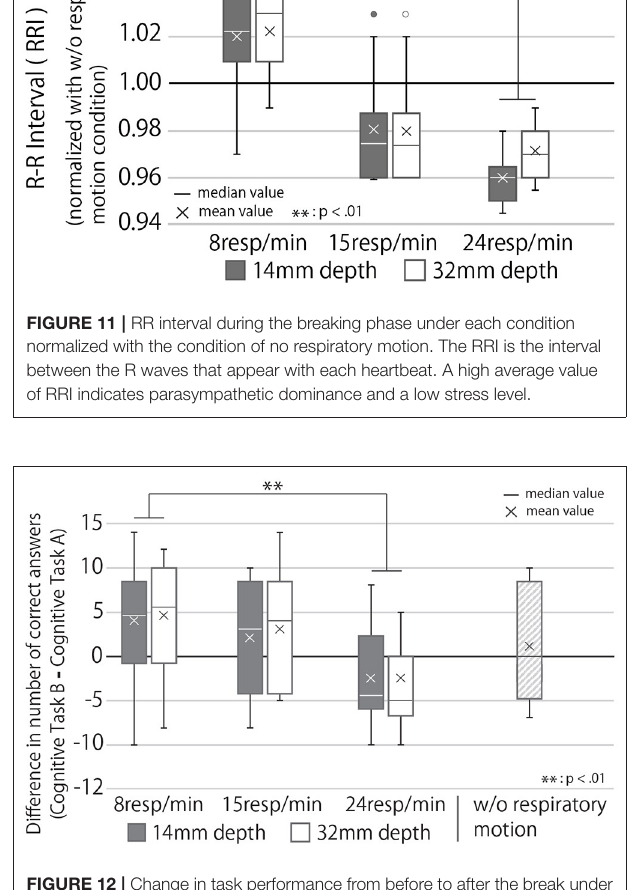
FIGURE 12 | Change in task performance from before to after the break under each condition. If the score is greater than zero, the task performance after the break with the device was better than that before the break.